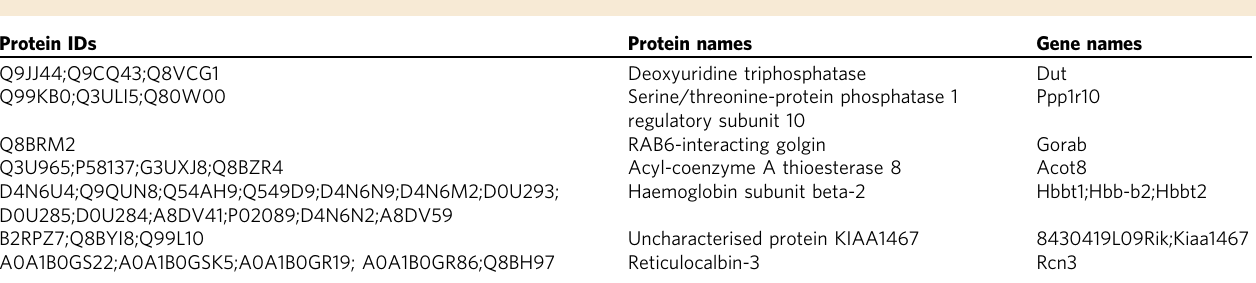
Table 1 Distinct proteins in